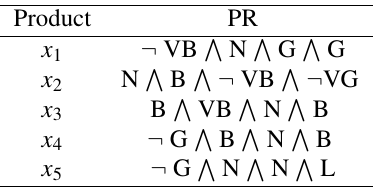
Table 6. The Relations among UT i s